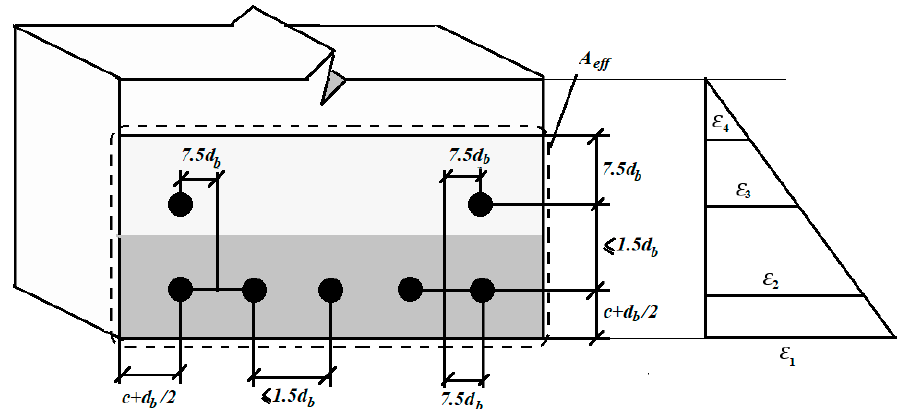
Figure 2. Calculation of the e ff ective area to determine the flexural crack spacing, according to NS 3473E 2003 [54]. CSA S474 [53] and NS 3473E [54] propose a similar formula to anticipate the crack spacing, with little variance in the slope of strain, which calculates the e ff ective rebar’s section. According to NS 3473E [54], the crack spacing is determined using the following relationship.